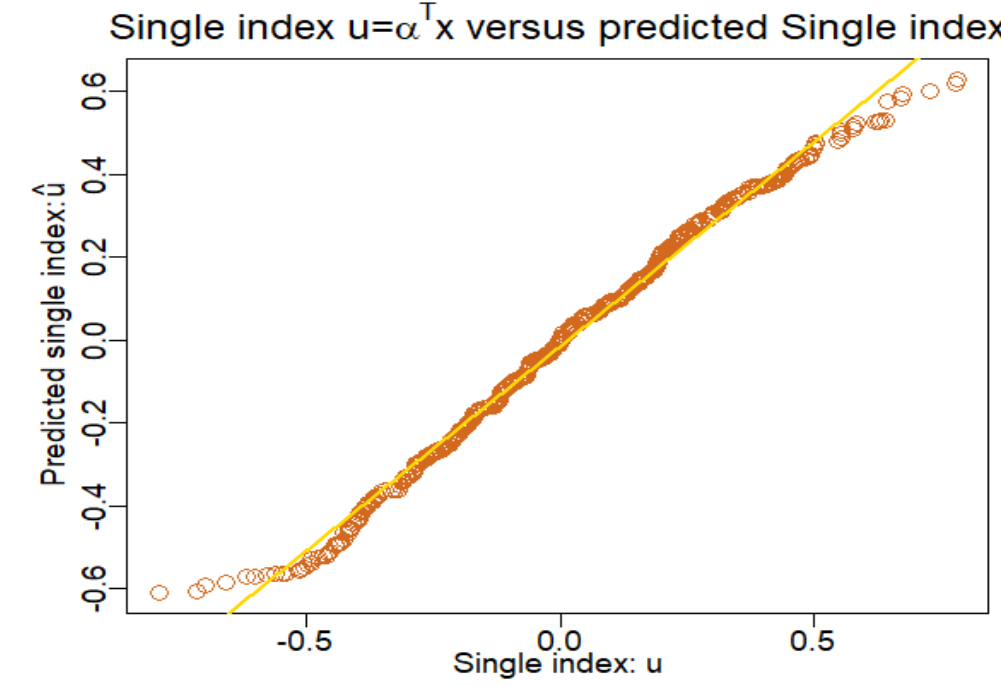
Figure 2. Single index u = α (cid:62) X versus predicted single index ˆ u = ˆ α (cid:62) X